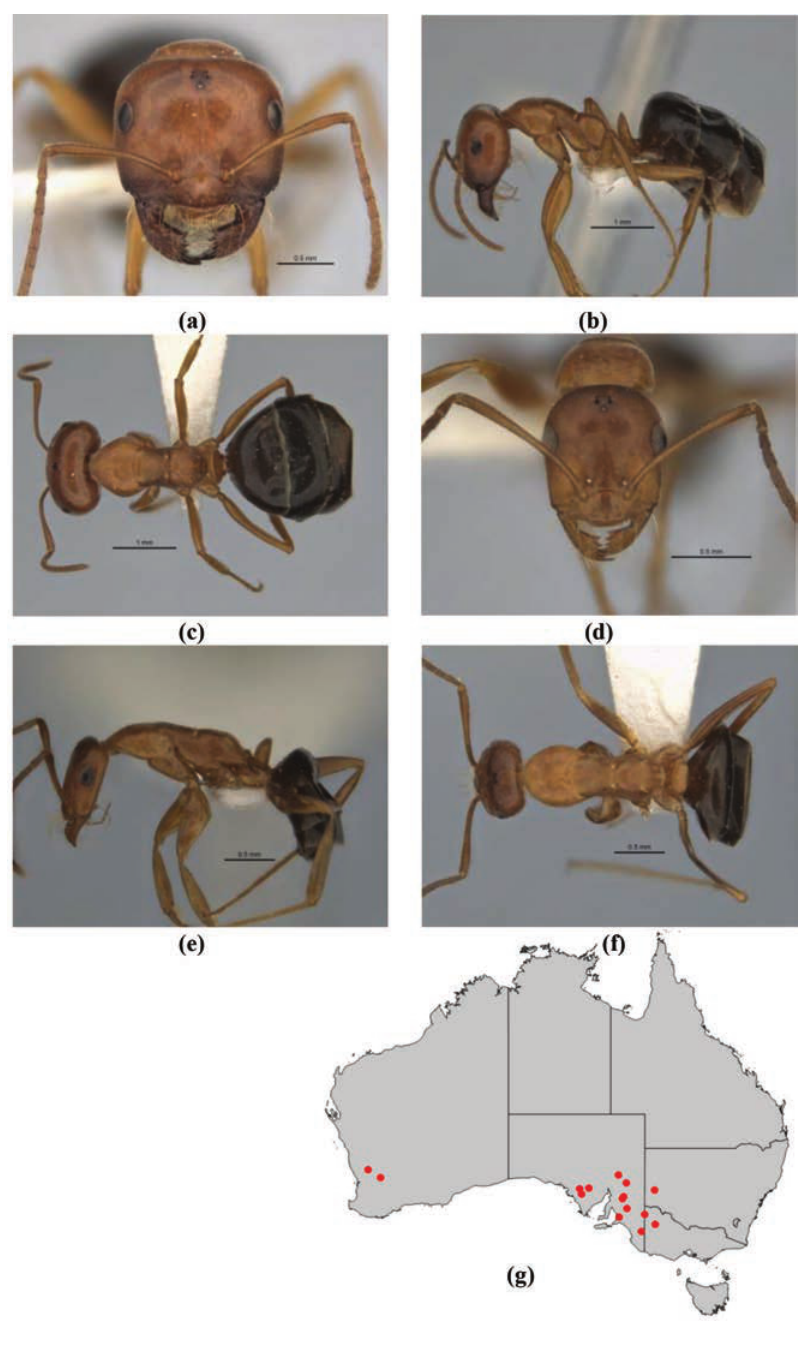
Figure 17. Melophorus platyceps sp. n.: major worker paratype (ANIC32-900117–top ant) frons ( a ), pro- file ( b ) and dorsum ( c ); minor worker holotype (ANIC32-900117–middle ant) frons ( d ), profile ( e ) and dorsum ( f ); distribution map for the species ( g ). Low resolution scale bars: 1 mm ( b, c ); 0.5 mm ( a, d–f